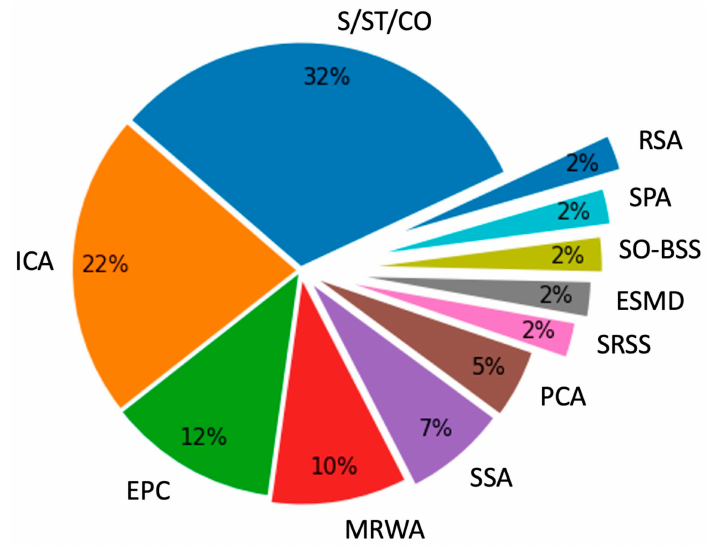
Figure 12. Breakdown of the data preprocessing